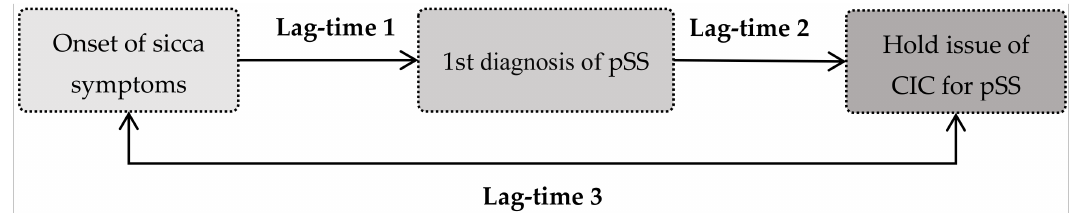
Figure 1. The time of lag before the diagnosis of primary Sjogren’s